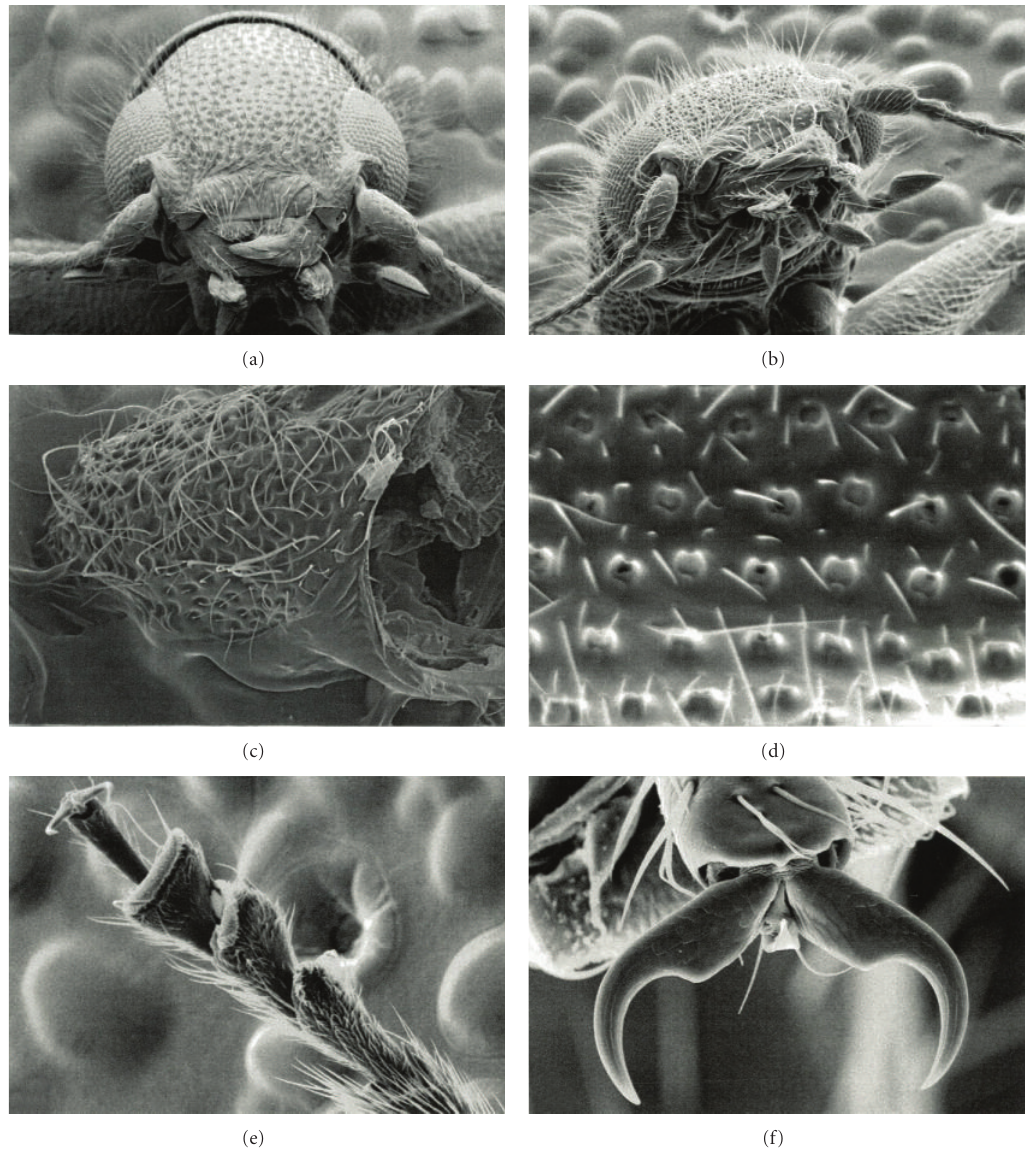
Figure 2: Various organs of Abiliella fasciata . (a) Head. (b) Mouthparts. (c) Pronotum (posterolateral angle). (d) Elytral surface (shows binodal asetiferous punctations). (e) Metatarsus. (f) Metatarsal unguis (shows absence of denticle).